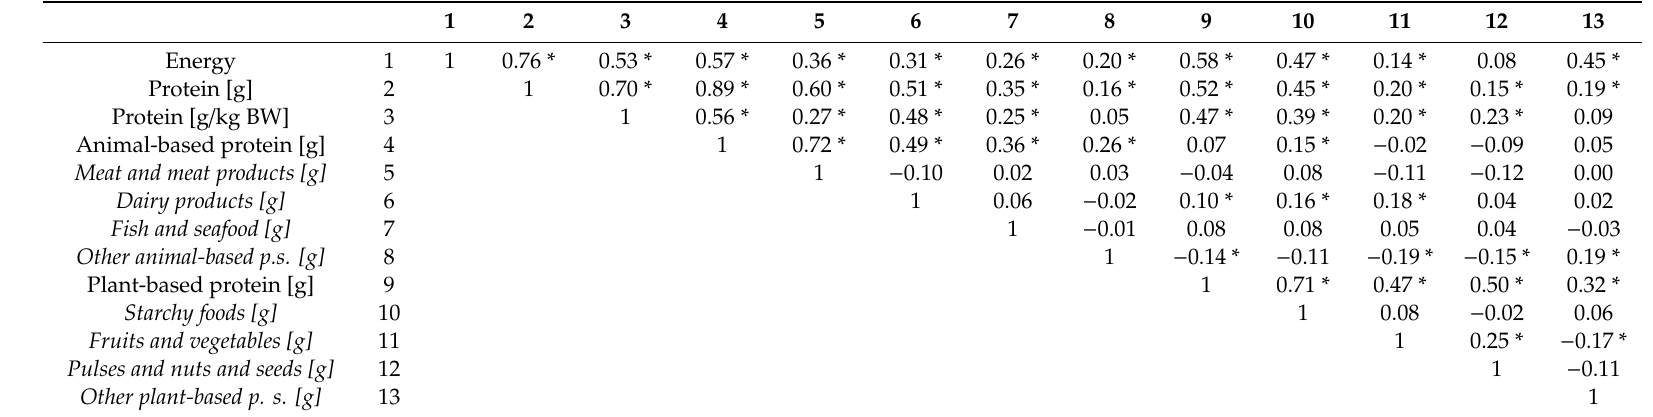
Table 2. Pearson correlations of data on protein